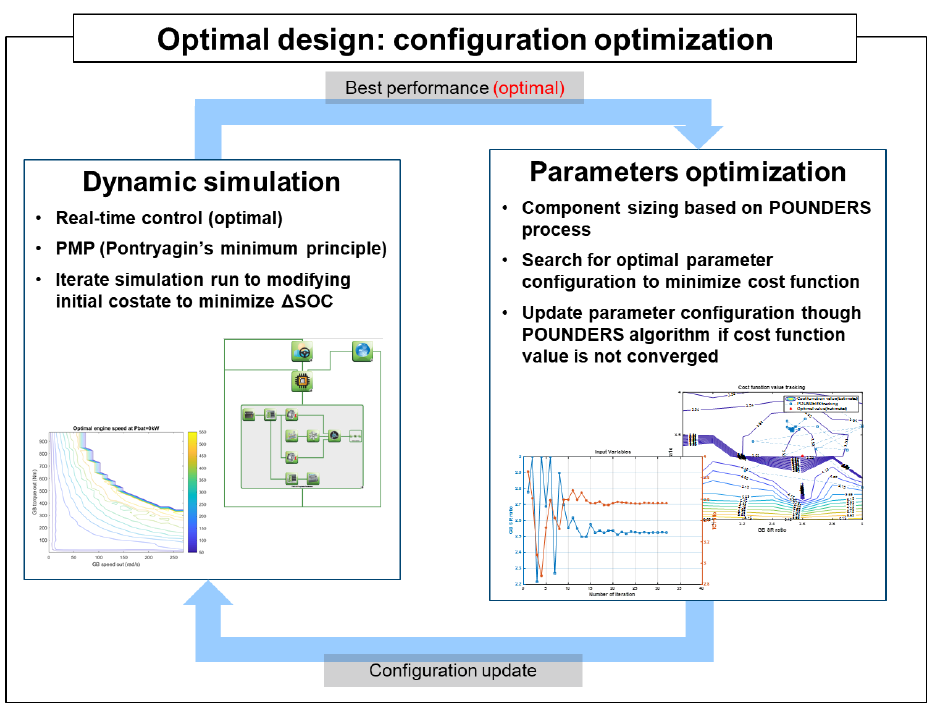
Figure 2. Component-sizing optimization process with vehicle simulation. The POUNDERS algo- rithm updates the parameter configuration to minimize the cost function value and vehicle simulation, with PMP runs targeting the driving cycles with updated parameter configurations from POUNDERS.